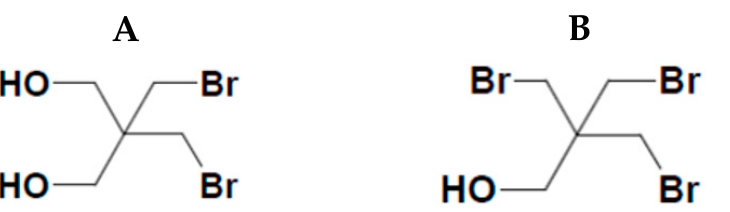
Figure 1. Molecular structure of ( A ) dibromoneopentyl glycol (DBNPG); ( B ) tribromoneopentyl alcohol (TBNPA). Table 2. Consortium biomass (OD600) at the end of the exponential phase, and time for complete degradation of TBNPA, DBNPG, or both TBNPA and DBNPG in consortia amended with YE, DL-vitamin mix, or glucose. Controls with no amendment did not lead to degradation and are not presented.